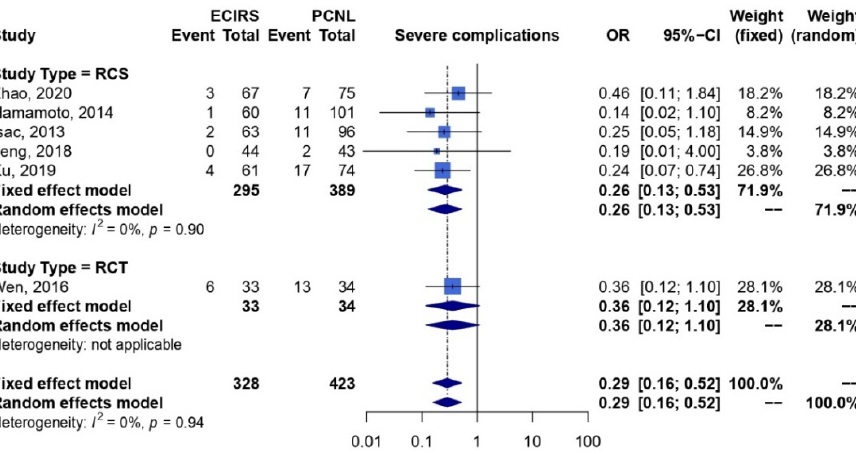
Figure A13. Subgroup analysis of outcome regarding severe complications. (RCS: [18–23]; RCT: [17]).